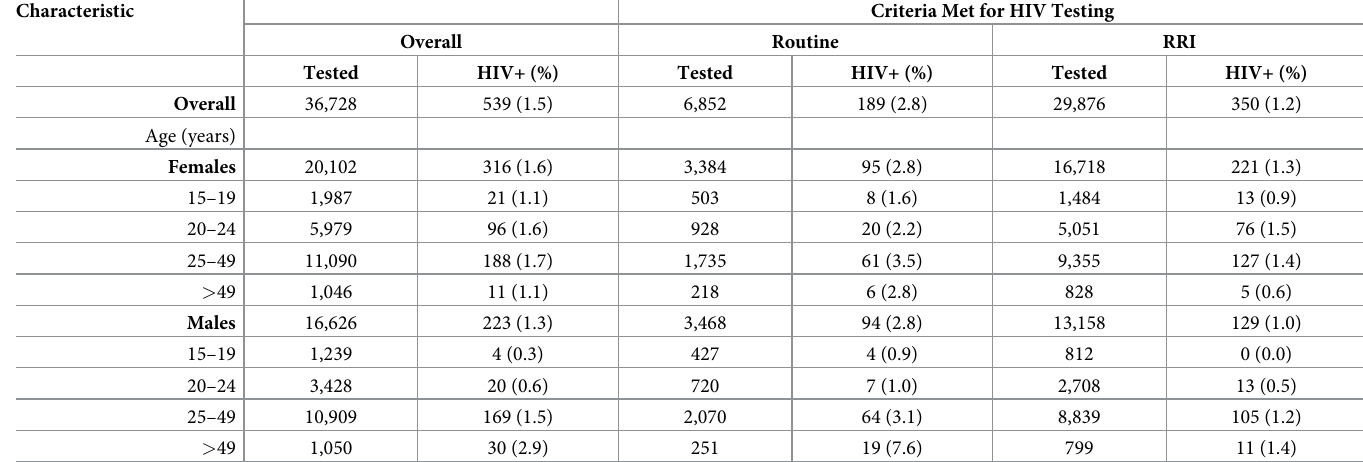
Table 5. Number and percent of non-patients with an HIV-positive test result by criteria met for testing, age and sex at selected facilities in Siaya, Kisumu and Homa Bay Counties, Kenya. Characteristic